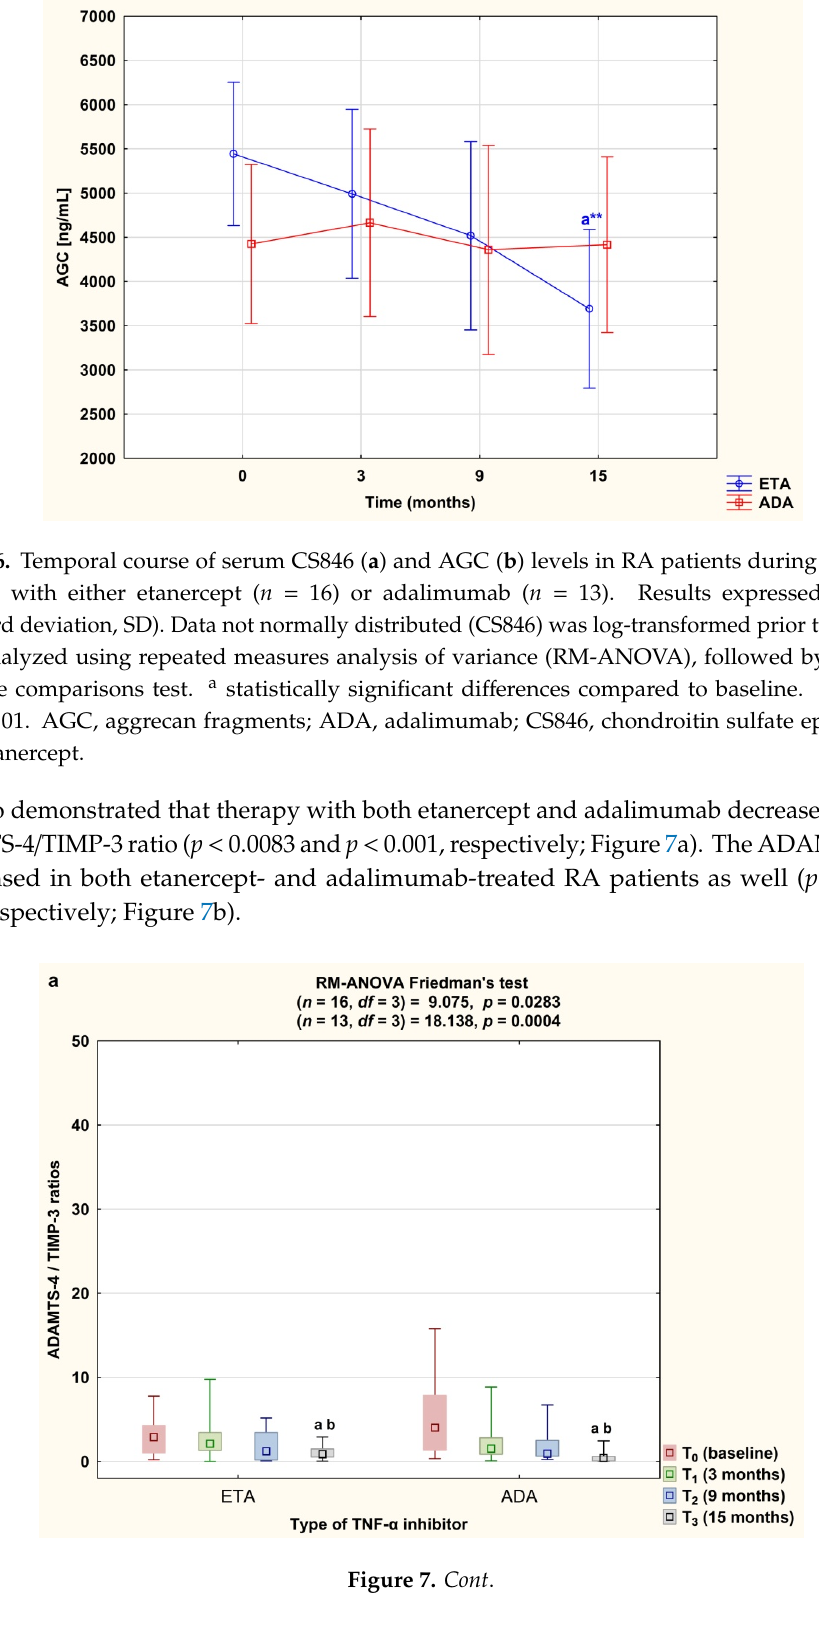
Figure 7. Temporal course of ADAMTS-4 to TIMP-3 ratios ( a ) and ADAMTS-5 to TIMP-3 ratios ( b ) in RA patients during 15-month therapy with either etanercept ( n = 16) or adalimumab ( n = 13). Results expressed as median and interquartile (25th–75th percentile) range and minimum–maximum. Data analyzed using repeated measures analysis of variance (RM-ANOVA) Friedman’s test. Differences noted for all variables considered significant at p < 0.0083 by applying Bonferroni correction. a statistically significant differences compared to baseline, b statistically significant differences compared to 3 months after therapy. ADA, adalimumab; ADAMTS-4 and ADAMTS-5, disintegrin and metalloproteinase with thrombospondin motifs 4 and 5; ETA, etanercept; RA, rheumatoid arthritis; TIMP-3, tissue inhibitor of metalloproteinase -3. 4. Discussion Prevention of early depletion of aggrecan in RA patients may contribute to slowing the progression of the disease and therefore to improved joint function. Our study demonstrates that